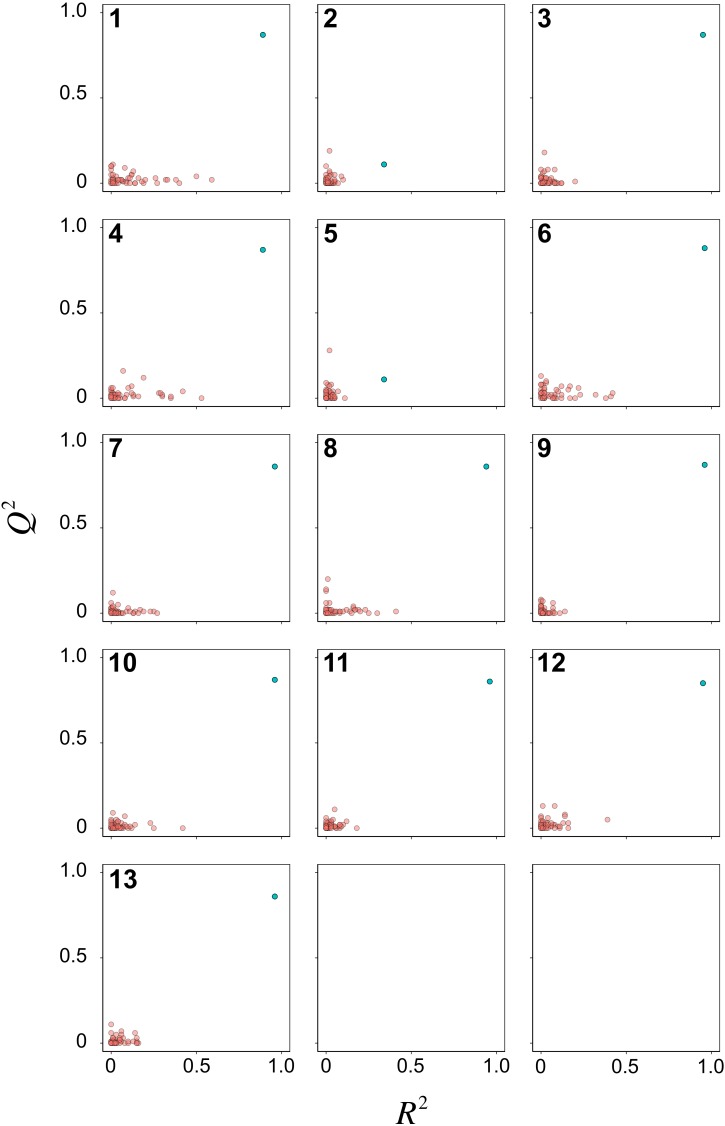
Y-scrambling plots of pIC50 as obtained from PCM models after feature selection.